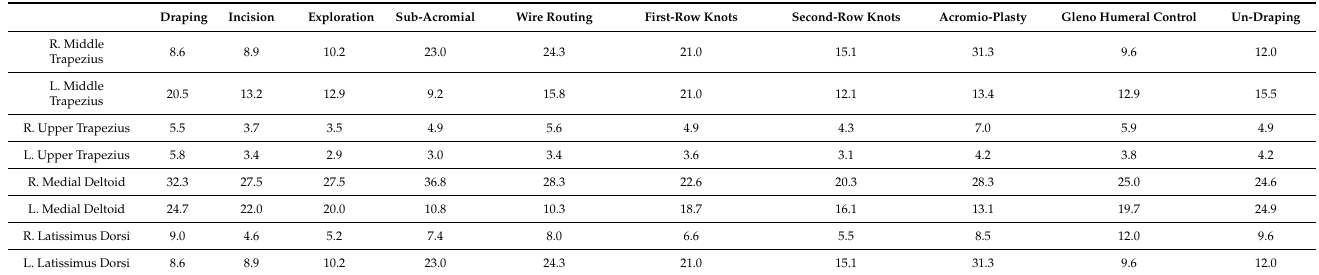
Table 3. RMS values ( µ V) from eight muscles during the different stages of the surgery.